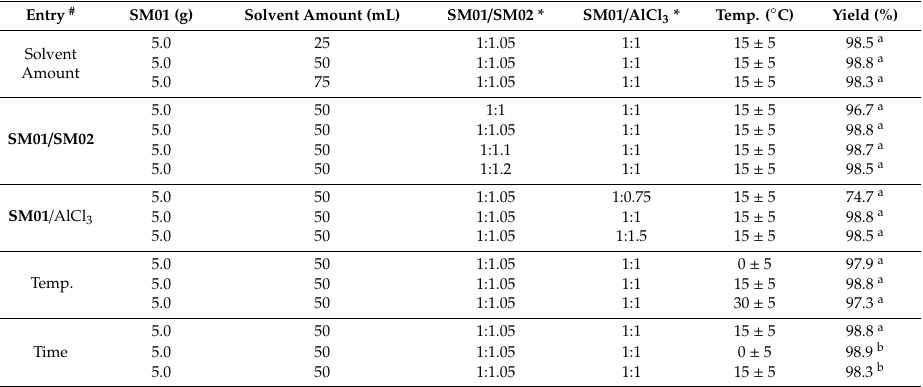
Table 1. Parameter optimization of synthetic process of LM49-01 .